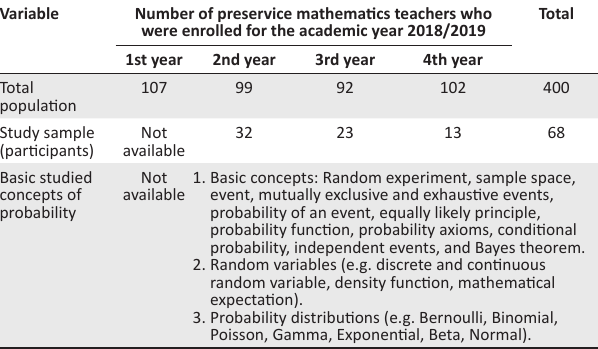
TABLE 1: The study population and